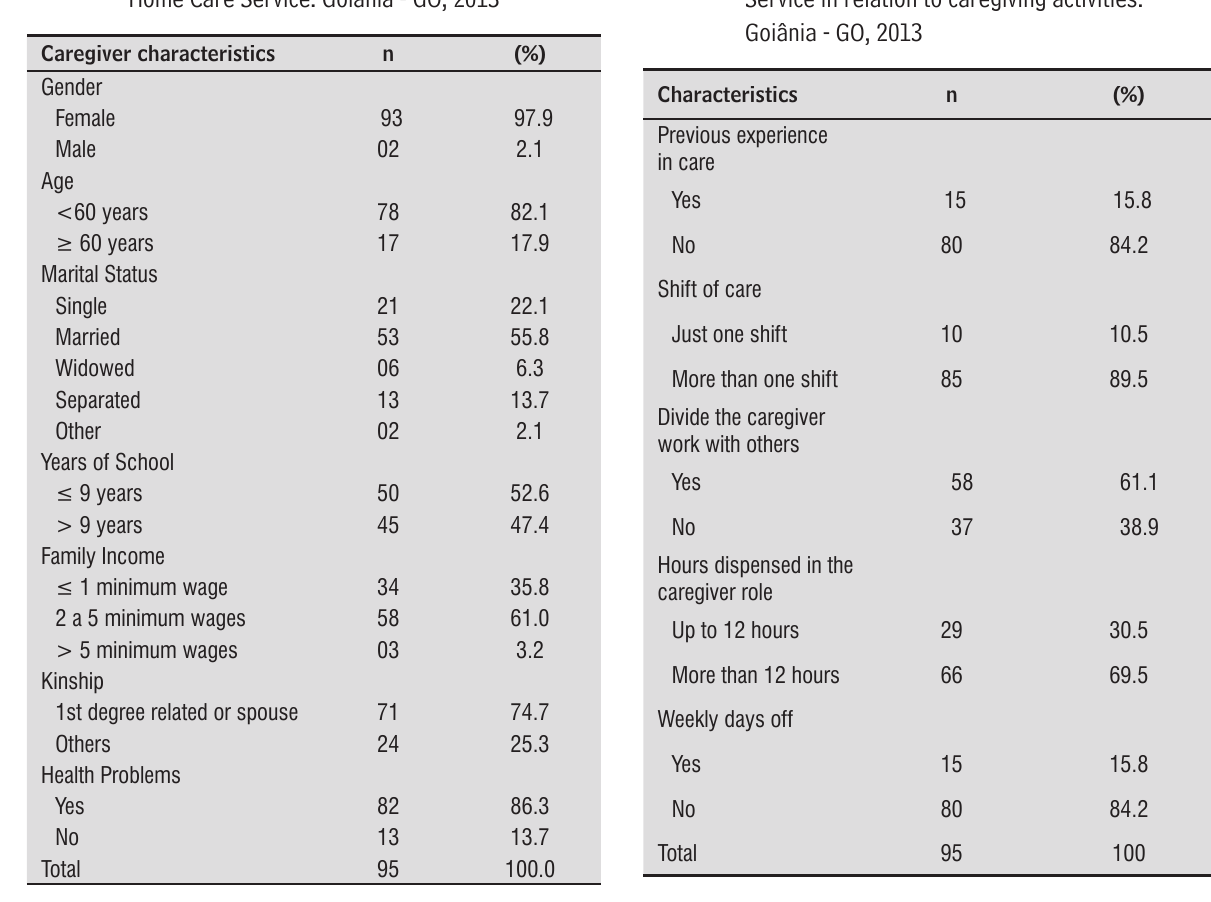
Table 1 - Distribution of characteristics of caregivers from Home Care Service. Goiânia - GO, 2013